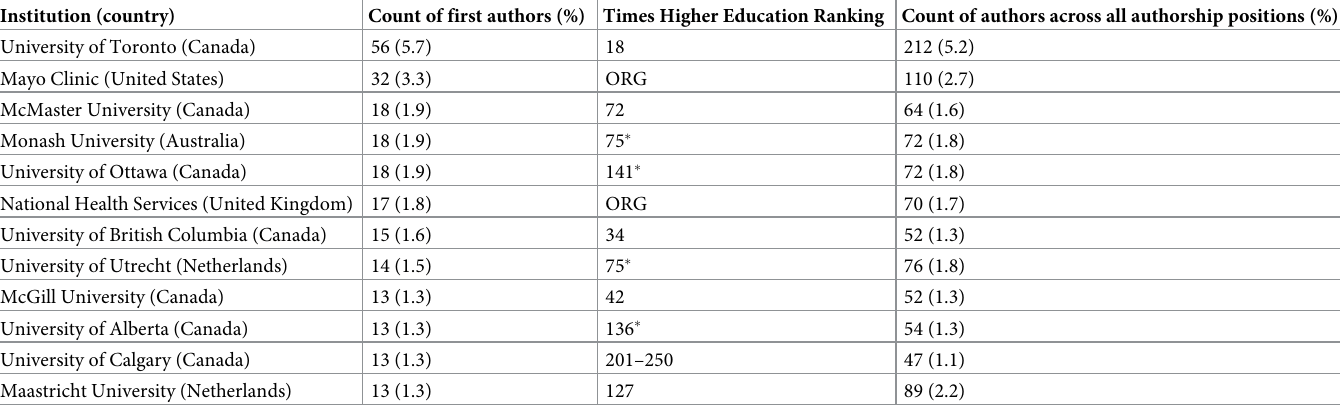
Rankings retrieved from Times Higher Education (THE) World University Rankings 2020. � indicates a tie in THE